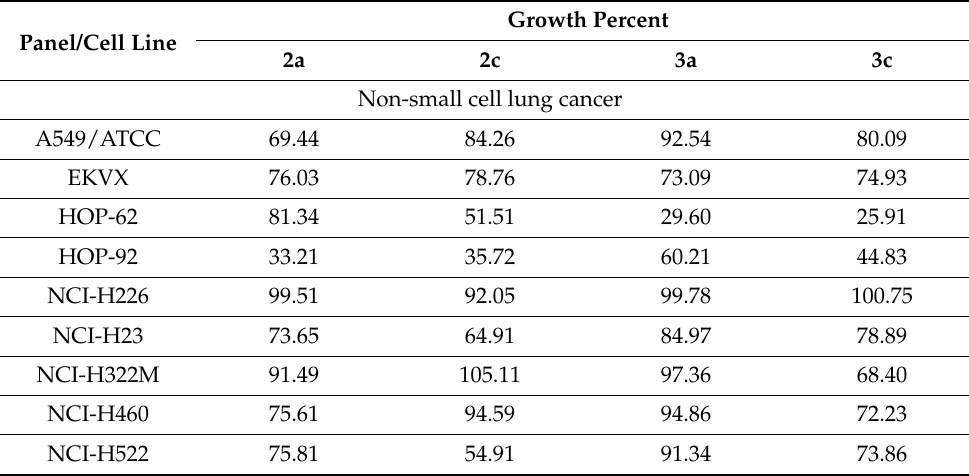
Table 1. Percentage of growth in the presence of the selected compounds ( 2a , 2c , 3a , and 3c ) and its absence (control) on sixty subpanel cell lines at a single concentration of 10 µ